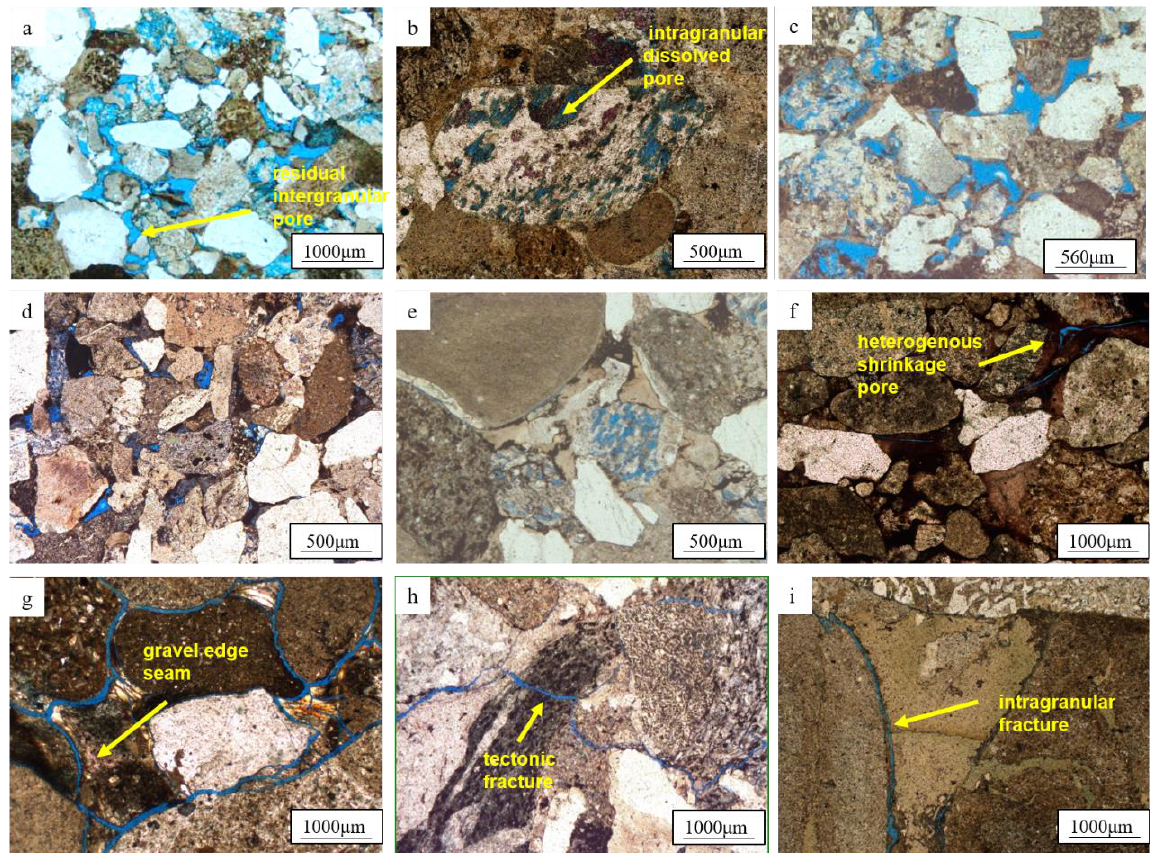
Figure 3. Microscopic characteristics of pore throat in low permeability conglomerate; ( a ) Well Ma18, 3922.83 m, sandy grain-supported conglomerate, residual intergranular pores and intragranular dissolved pores; ( b ) Well Ma-604, 3858.84 m, gravelly coarse sandstone, intragranular dissolved pores; granular pores; ( e ) Well Ma-601, 3862.78 m, argillaceous-supported conglomerate, intragranular dis- solved pores; ( f ) Well Ma18, sandy-gravelly matrix-supported conglomerate, matrix shrinkage